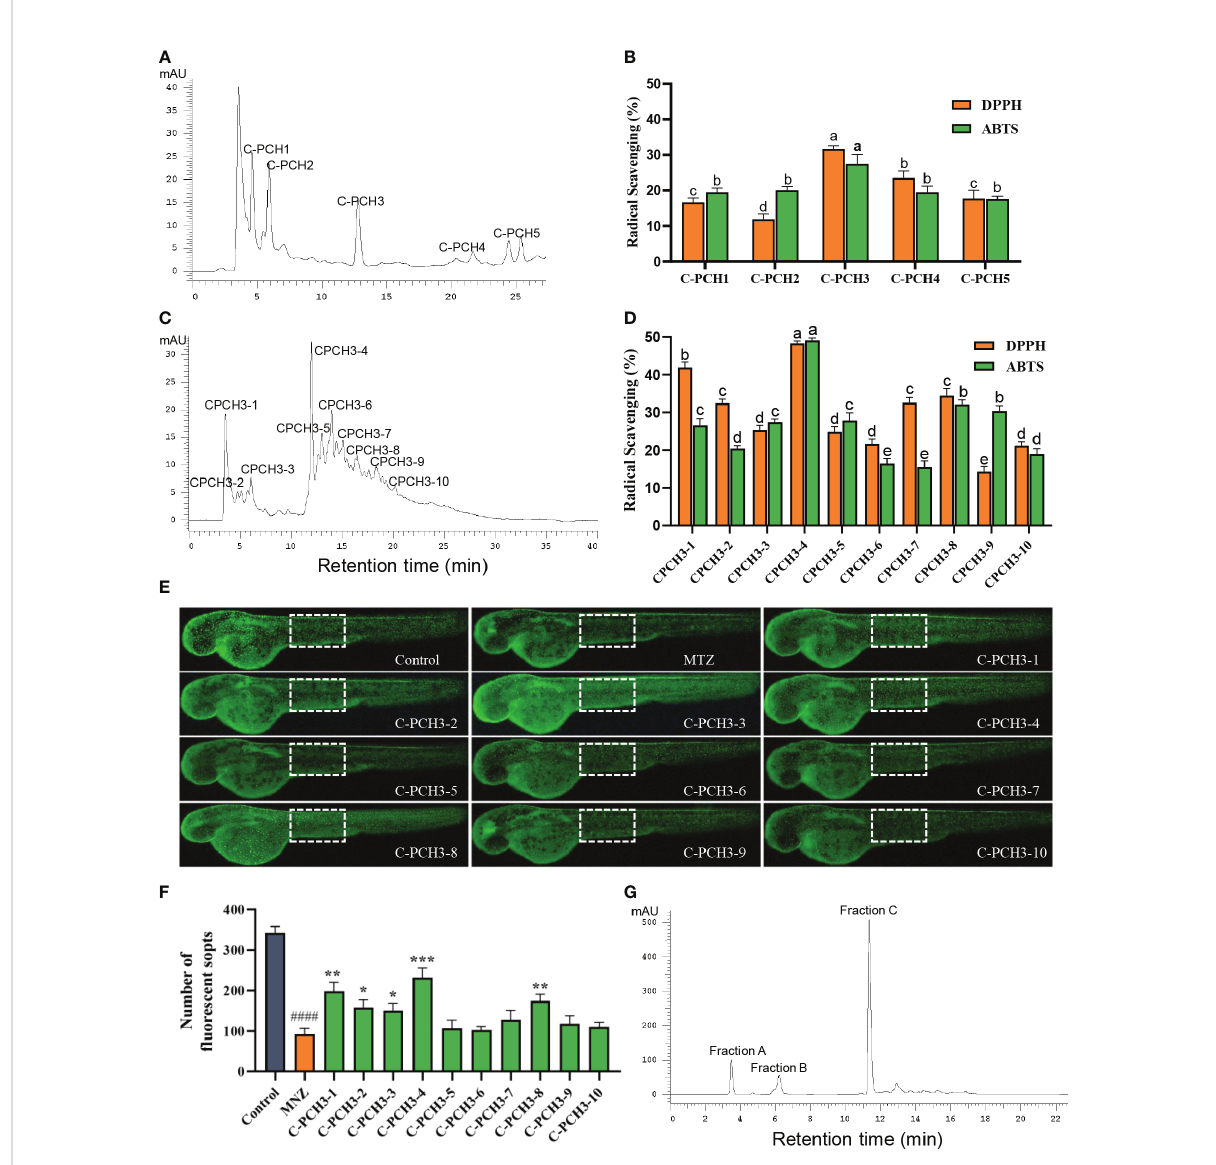
FIGURE 2 Puri fi cation of antioxidant peptides from C-PC hydrolysates (C-PCH). (A) Separation of C-phycocyanin hydrolysate (C-PCH) by Sephadex G-100 gel fi ltration chromatography. (B) Radical scavenging activities of corresponding subfractions. (C) Further separation of C-PCH3 by Sephadex LH-20 gel fi ltration chromatography. (D) Radical scavenging activities of corresponding subfractions. a-e Values with the different letters indicate a signi fi cant difference ( p < 0.05). All data were expressed as mean ± standard deviation of triplicate experiments. (E) In vivo antioxidant activity of transgenic fl uorescent zebra fi sh Tg( krt4:NTR-hKikGR ) cy17 treated with MTZ (10 mM) and C-PCH3-1 to C-PCH3-10 (50 m g/mL). (F) FS number statistic results of all groups. Data are represented as the mean ± SEM (n=15). *p < 0.05, **p < 0.01, ***p < 0.001 compared with the MTZ group. ####p < 0.0001 compared with the control group. Scale bar, 200 m m. (G) Puri fi cation of C-PCH3-4 by RP-HPLC on a 300 Extent-C18